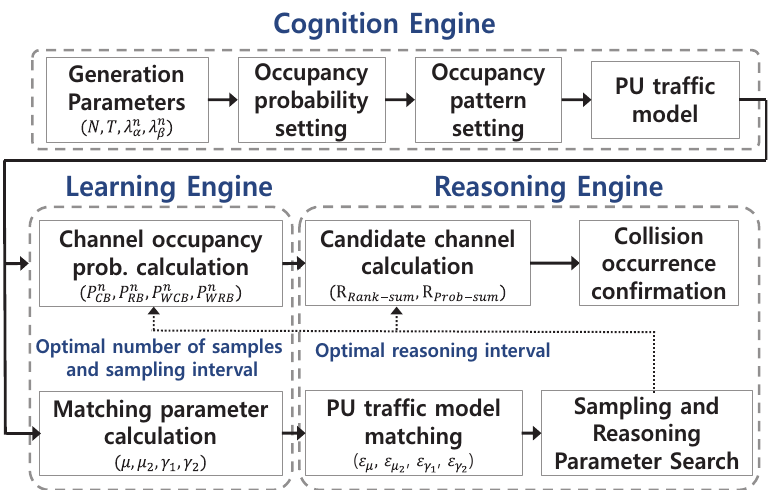
Figure 9. Simulation analysis